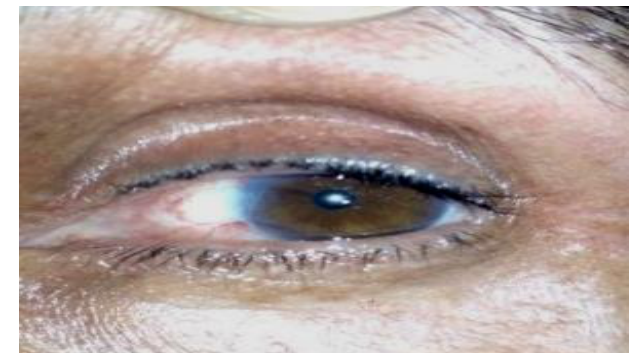
Fig. 4. Resolution of thinning after patching the eye (Day 14 after Surgery).